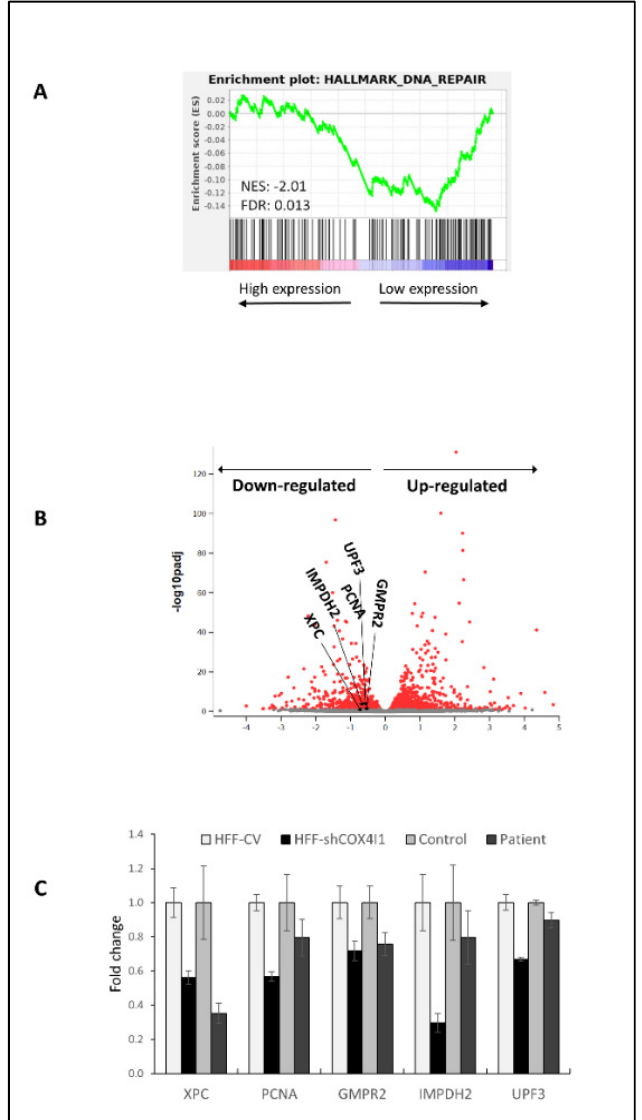
Figure 2. CEL-Seq2 analysis identifies DNA repair as one of the top downregulated pathways in COX4-1-deficient cells. Total RNA was isolated from human foreskin fibroblast cell line (HFF) and transfected with a control vector (HFF-CV) or HFF with downregulated COX4I1 (HFF-shCOX4i1). A HiSeq assay CEL-Seq2 analysis was performed and analyzed with the DESeq2 package. Signif- icance threshold was set as FDR < 0.1. Downregulation of DNA repair was detected by gene set enrichment analysis (GSEA). NES: normalized enrichment signal; FDR: false discovery rate ( A ). In the volcano plot, each dot represents a gene ( B ). The x-axis indicates the log2 (fold change) of the ex- pression of HFF-shCOX4I1 relative to healthy control fibroblasts, and the y-axis reflects − log10 of the FDR-adjusted p -value of this comparison. The colored dots pass the threshold for FDR. ( C ) Selected DNA repair genes in the volcano plot (XPC, PCNA, GMPR2, IMPDH2, UPF3) were validated by RT- qPCR in both COX4-1-deficient cells (HFF-shCOX4i1 and patient) and their corresponding controls. Values of RT-qPCR validation are presented as the log2 (fold change) in ± SD of biological